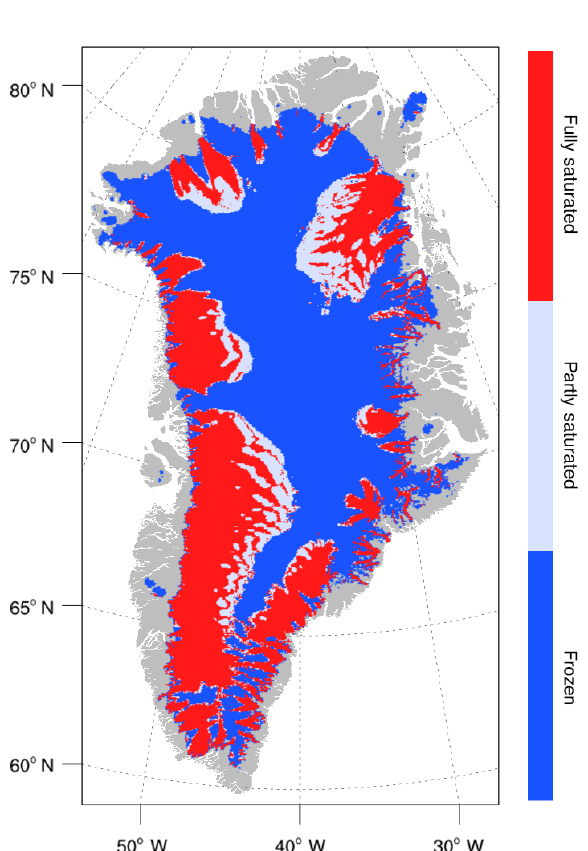
Figure 11. Difference (m) between (1) simulated ice thickness at the end of a 50kyr Greenland spin-up without ice shelves and (2) observed thickness from Morlighem et al. (2014). The observed thickness is the model initial condition. The gray background shows regions that are ice-free at both the beginning and end of the simu- lation.